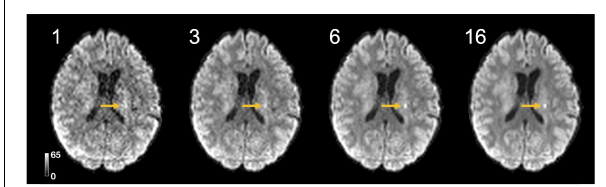
FIGURE 7 | High-quality high b -value STE-DWI ( b = 2,000 s/mm 2 ) images can be obtained with short scan times and few averages. The tumor-related hyperintensity is visible with 3 averages (yellow arrows), but becomes clearer with 6 averages and yields an image quality similar to that obtained with 16 averages. With a repetition time of 5,000 ms, 6 averages can be acquired in 30